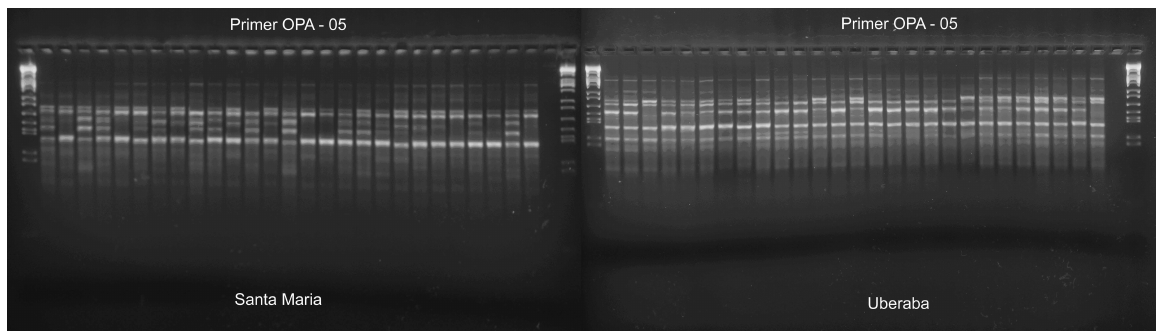
Fig. 1 – Intra specific variation OPA-05 obtained by genomic DNA amplification of Chlosyne lacinia saundersii from Santa Maria, RS and Uberaba, MG. As molecular marker the fago Lambda DNA, digested with the Eco RI, Hind III, and Bam HI endonucleases, was used.